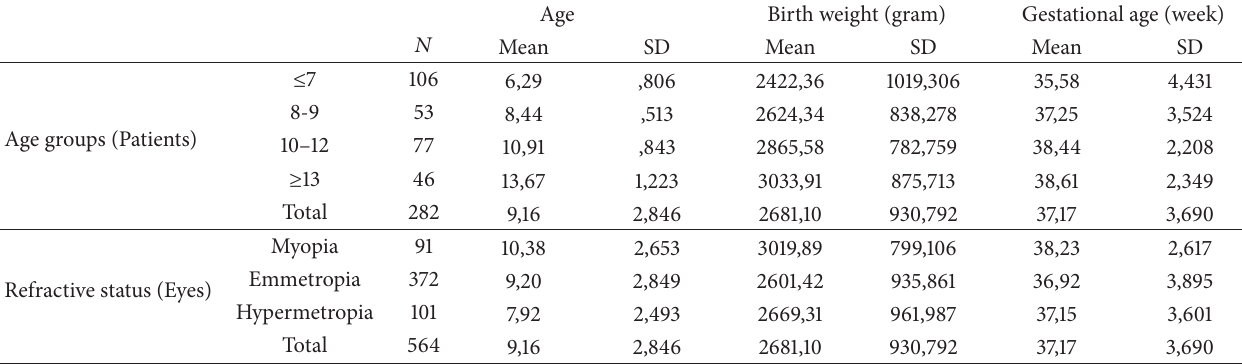
Table 1: The mean age, birth weight, and gestational age distribution according to age groups and refractive status. Age Birth weight (gram) Gestational age (week) 𝑁 Mean SD Mean SD Mean ≤ Age groups (Patients)